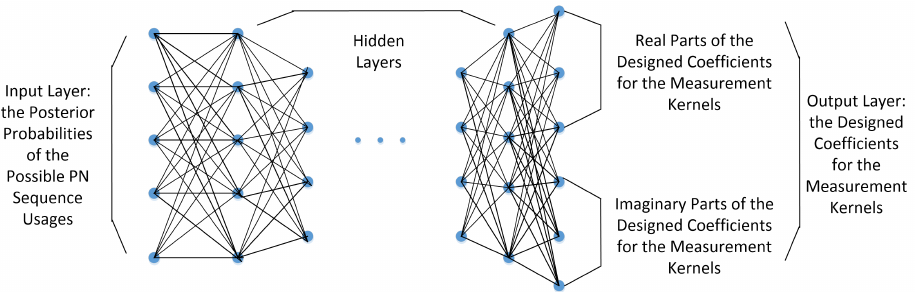
Figure 2. The Architecture of the Artificial Neural Networks in the Adaptive Measurement Ker- nel